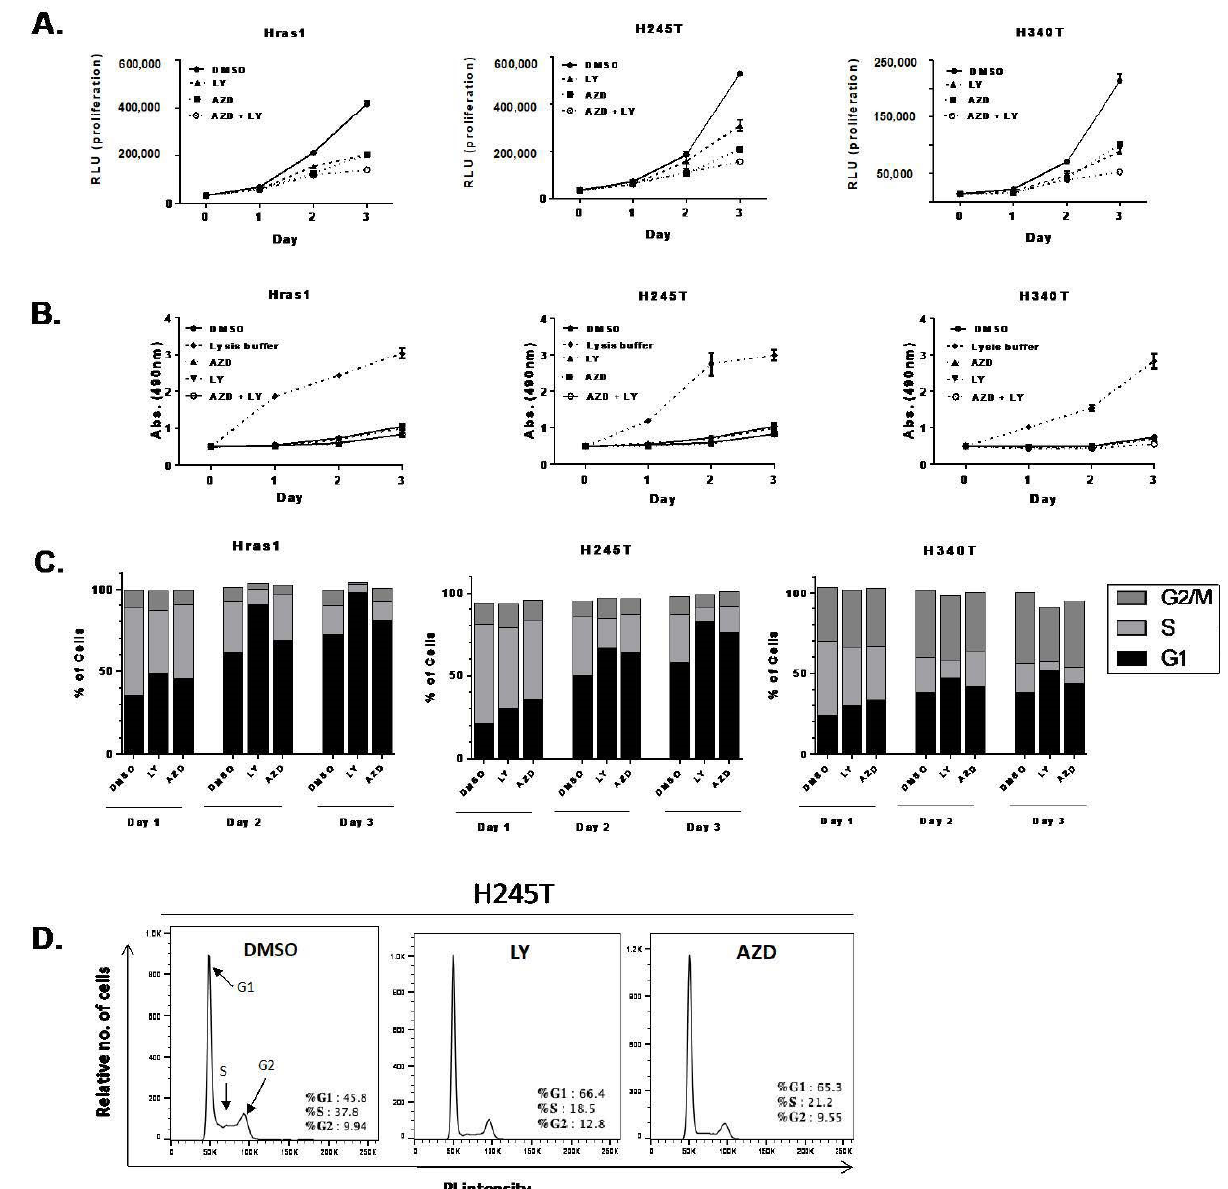
Figure 4. Growth suppressive effects of MEK and PI3K inhibition in Hras G12V /Pten − / − /TPO Cre cell lines. ( A ) Growth curves of thyroid tumor cell lines (Hras1, H245T, and H340T) treated with MEK inhibitor (AZD:AZD6244), PI3K inhibitor (LY: LY294002) or combination of MEK and PI3K inhibitors (AZD + LY). Day 0 represents 18 h after plating equal numbers of cells. Results compared to treatment with vehicle alone (DMSO). ( B ) Analysis of cell cytotoxicity in thyroid tumor cell lines via colorimetric detection of lactate dehydrogenase (LDH) in cell supernatant. Cells were treated with MEK and PI3K inhibitors for 72 h prior to analysis. Lysis buffer treatment simulates maximum potential LDH release at given measure- ment time point. ( C ) Summary cell cycle analysis results of cells treated with MEK and PI3K inhibitors for 72 h. Results demonstrate relative DNA content and corresponding percentage of cells in G1, S, and G2/M phase. ( D ) Representative FACS analysis of propidium iodine staining in H245T cell line treated with MEK and PI3K inhibitors. Results demonstrate a decrease in the relative number of cells in S phase and an increasing number of cells in the G1 phase. For all data, representative experiments out of 2 are shown. Each sample was analyzed in triplicate ( n = 3).